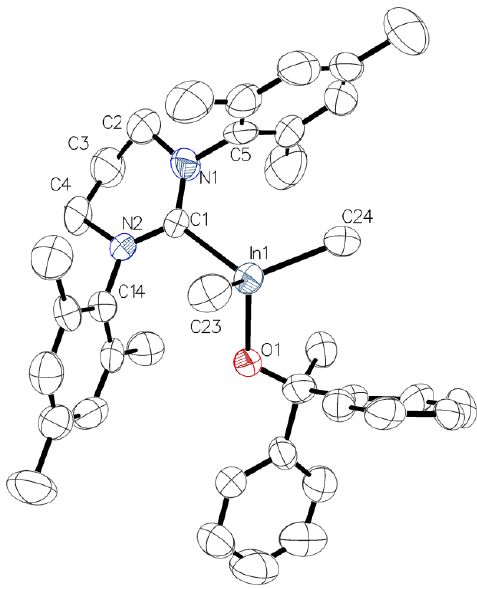
Figure 4. Molecular structure of 4 with thermal ellipsoids at 50% probability level. Selected bond lengths [Å ] and angles [°]: In(1)–O(1) 2.081(8), In(1)–C(1) 2.331(10), In(1)–C(23) 2.180(13), In(1)–C(24)